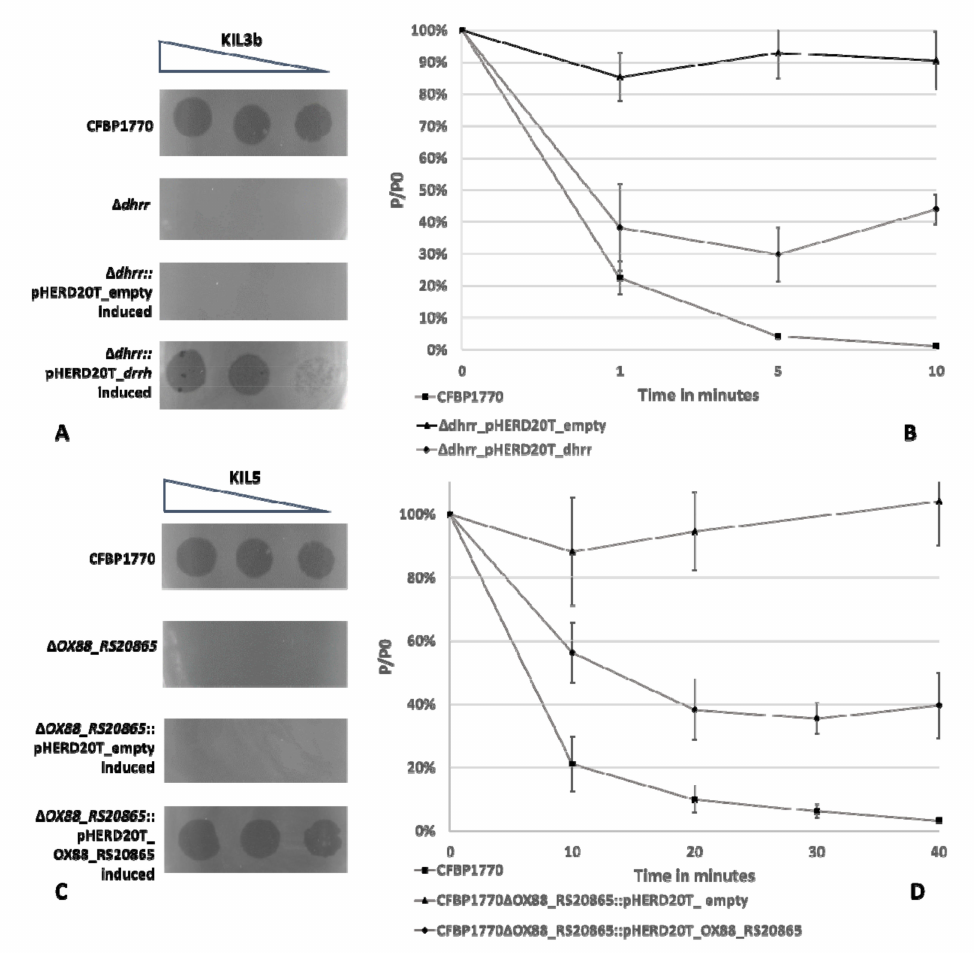
Figure 1. Complementation assay to test the e ff ect of di ff erent genes on phage infection and adsorption. ( A ) Spot assay of KIL3b (10 8 , 10 7 and 10 6 PFU / mL) on a lawn of Pseudomonas syringae pv. porri (Pspo) CFBP 1770, CFBP 1770 ∆ dhrr , CFBP 1770 ∆ dhrr ::pHERD20T_empty (induced) and CFBP 1770 ∆ dhrr ::pHERD20T_ dhrr (induced), respectively. Expression of dTDP-4-dehydrorhamnose reductase (Dhrr) indeed restores phage infection. ( B ) Adsorption assay of KIL3b on CFBP 1770 (square), CFBP 1770 ∆ dhrr::pHERD20T_empty (induced) (triangle) and CFBP 1770 ∆ dhrr ::pHERD20T_ dhrr (induced) (diamond) in which the percentage of non-adsorbed phages is plotted as a function of